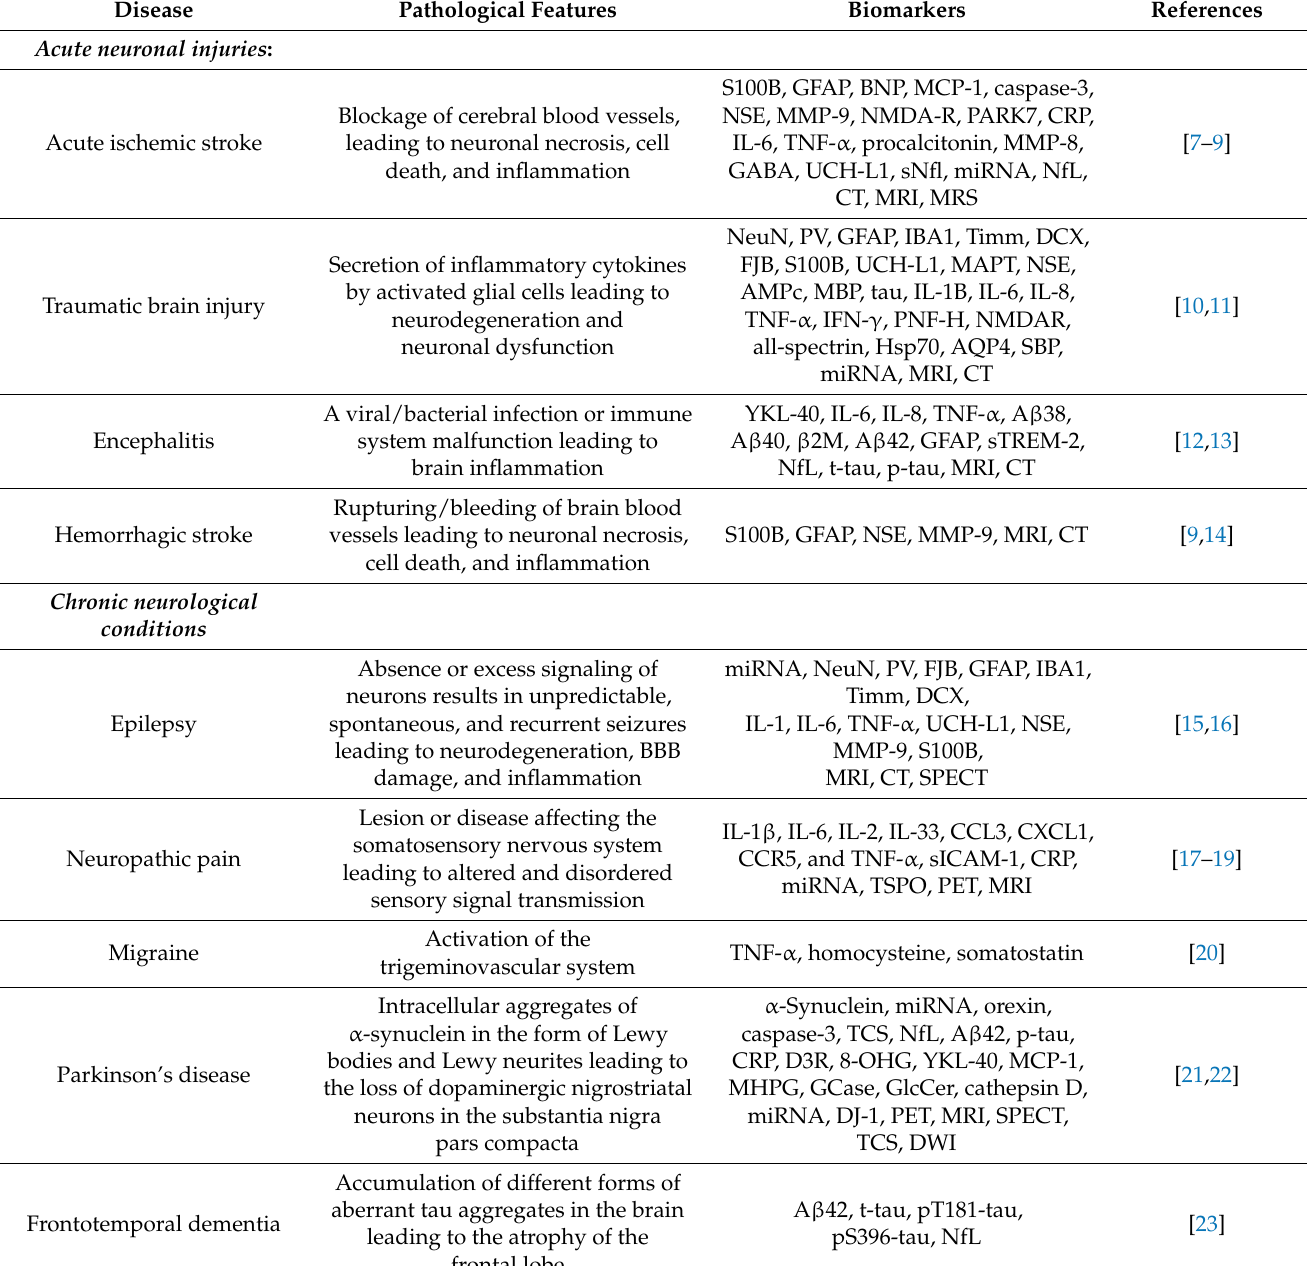
Table 2. Potential biomarkers in acute neuronal injuries and neurological